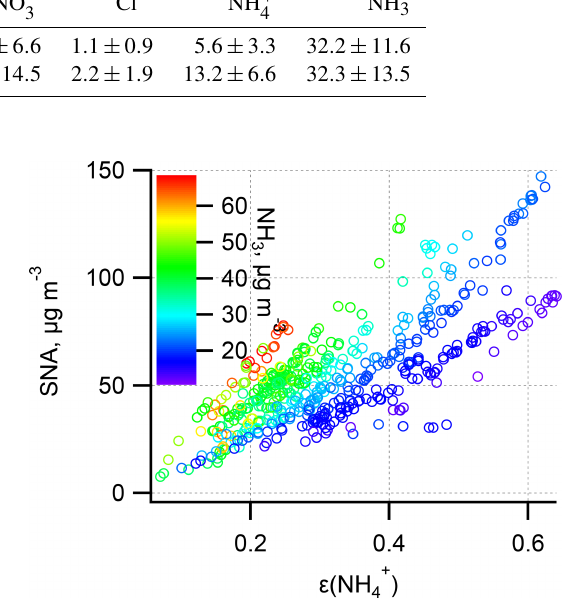
Figure 5. SNA mass concentration in PM 2 . 5 as a function of ε (NH + ) during the haze period. The circles are colored according 4 to the NH 3 mass ) and 4